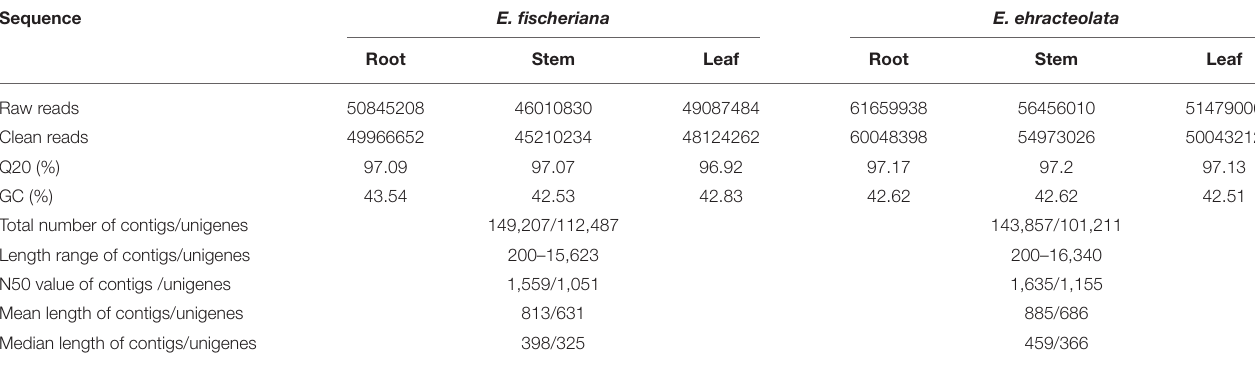
TABLE 1 | Summary of assembly results for E. fischeriana and E. ehracteolata using trinity.